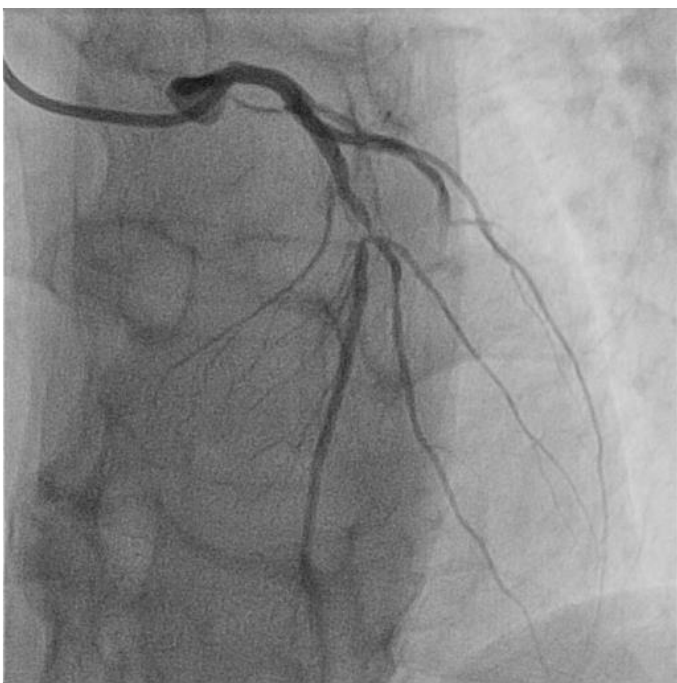
Figure 2. Selective angiography of the left coronary artery. Severe focal atherosclerotic narrowing of the proximal segment of left anterior descending coronary artery.